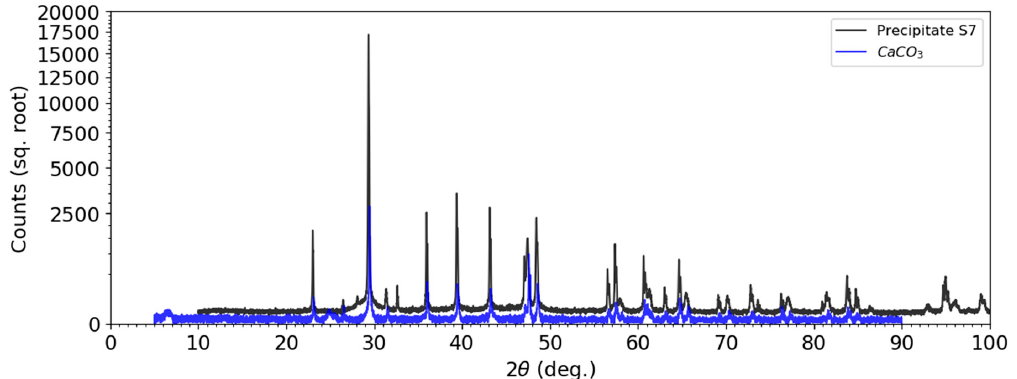
Figure 5. XRD patterns of precipitates produced by biostimulated soil (1) bacteria grown in CaCl 2 precipitation media. Counts in arbitrary units. CaCO 3 is calcite reference RRUFF R040070.